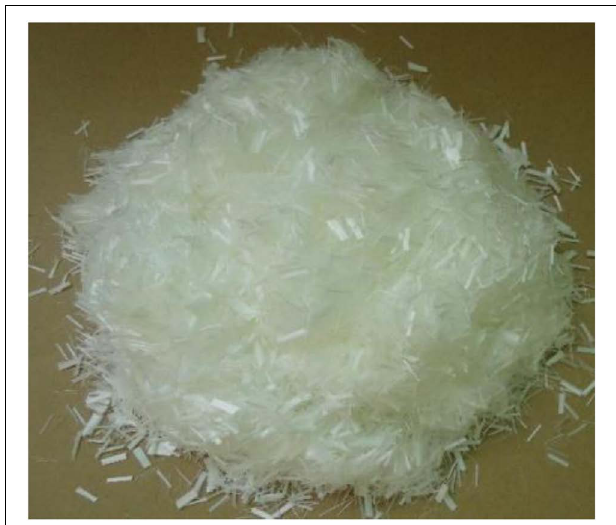
FIGURE 1 | Polyvinyl alcohol fibers.